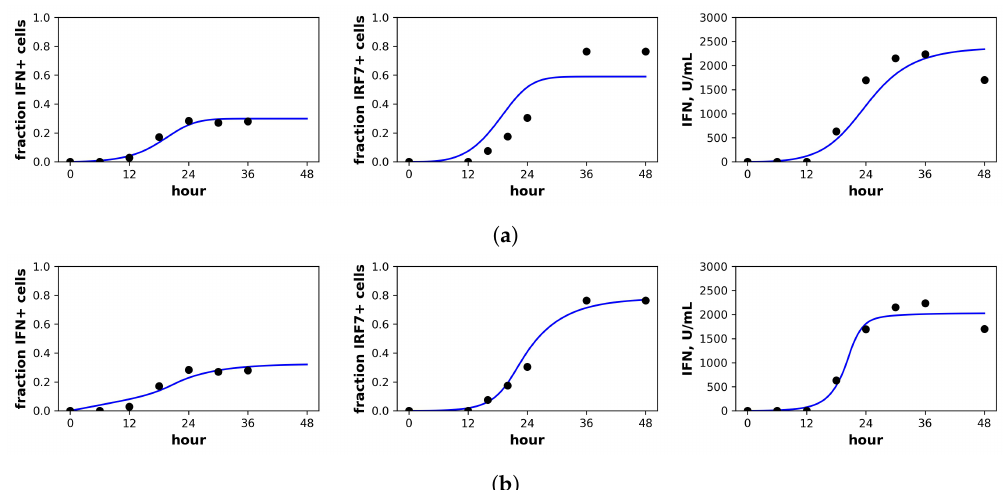
Figure 4. Fit of the extended model to Rand et al.’s dataset. Shown is the fit of our extended model assuming a ( a ) constant secretion rate and ( b ) pulsed secretion rate model. Panels, from left to right, show the fraction of cells expressing IFN mRNA, IRF7 mRNA and the extracellular IFN concentration. The pulsed rate model captures the rapid increase in IFN concentrations between 12 h and 24 h. Table 3. Fitted parameters for Rand et al.’s dataset under constant and pulsed secretion rate models. Parameters not shown were set to values determined in Rand et al; see Table S1 in the Supporting Information. SSE is the sum of squared errors. Confidence intervals are at 95% level. IFN units are U/mL, and viral load units are HN/mL; see Table 2 for the units of each parameter.